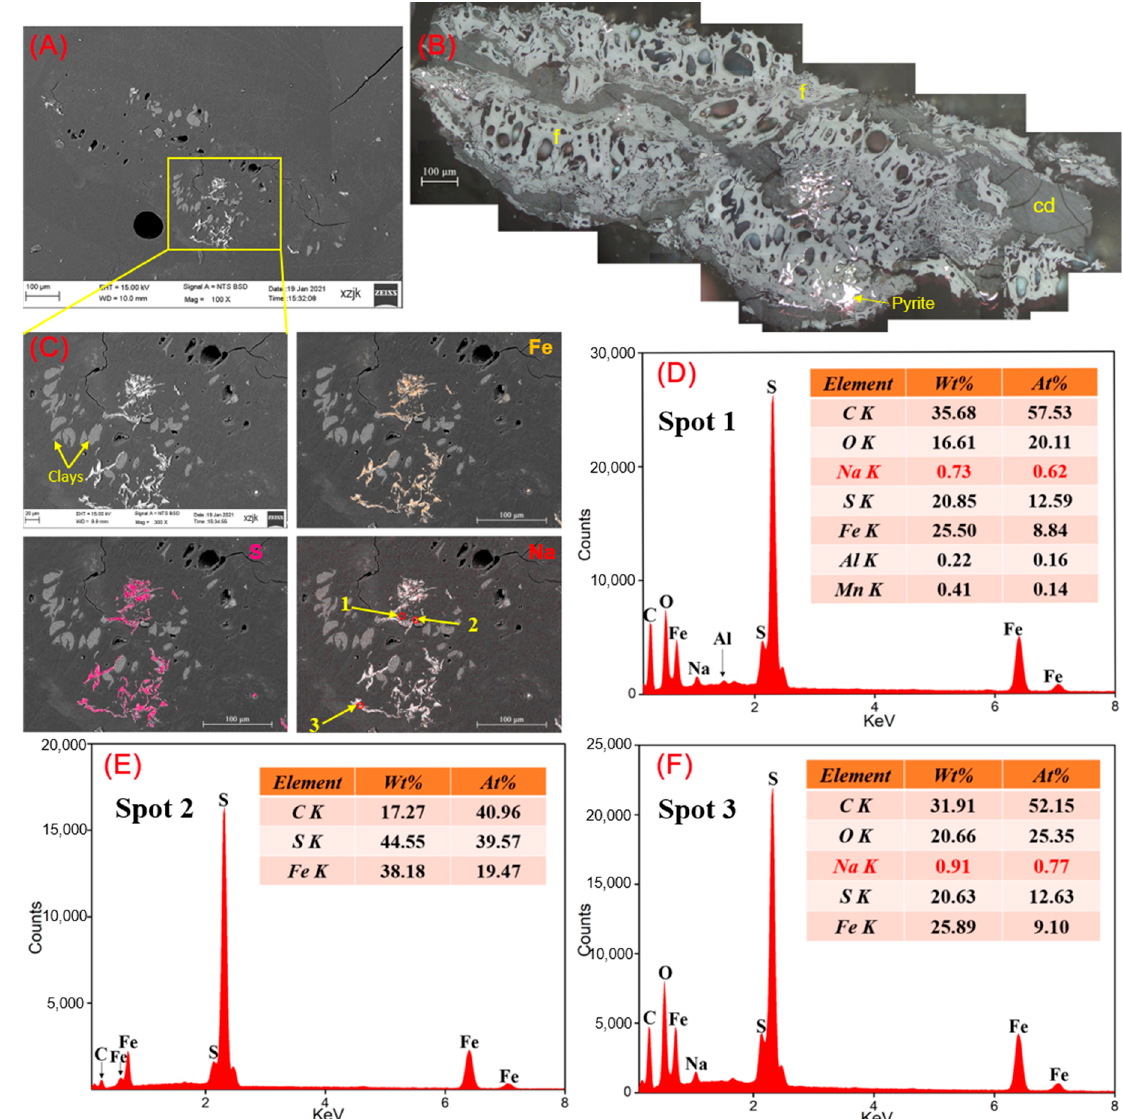
Figure 6. Microscope and SEM–EDS identification of DLTI: ( A ) SEM image of ( B ); ( B ) A fusinite (f) particle adorned by a long ribbon-shaped collodetrinite (cd) on edge and cracks, accompanied by some cell-filling pyrite; ( C ) Magnified SEM image of the yellow-boxed area in ( A ); ( D – F ) are EDS spectra from Spots 1, 2 and 3, respectively.